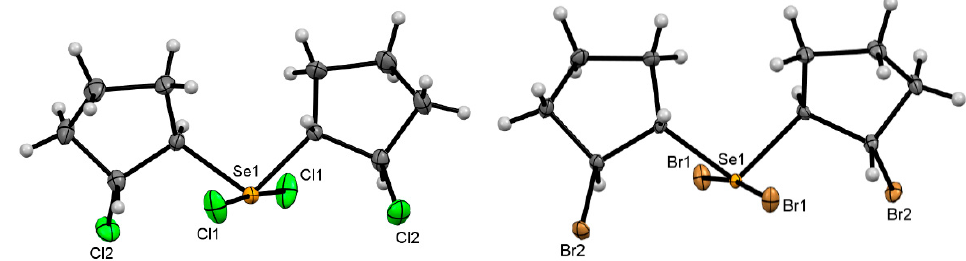
Figure 1. ORTEP molecular structure of selanes 9a and 10a (50% thermal ellipsoid probability).